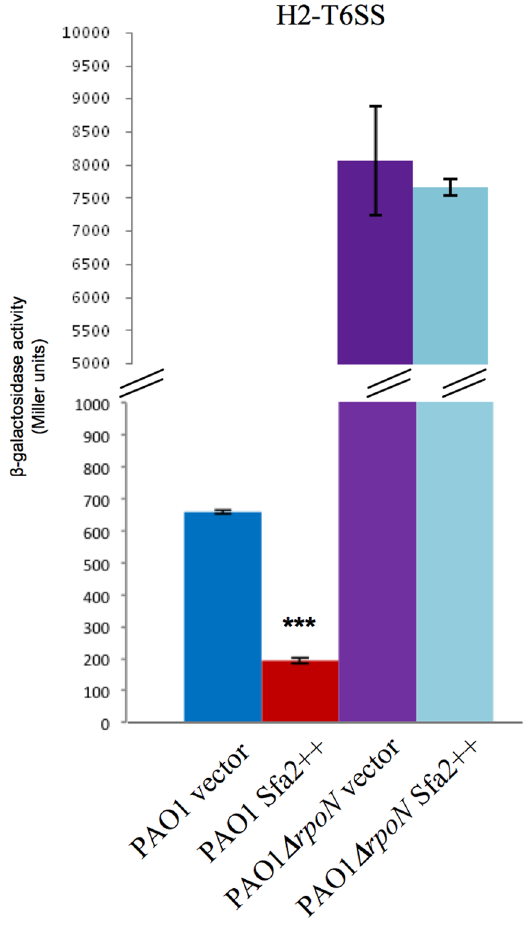
Figure 6. Sfa2 mediates down-regulation of H2-T6SS by RpoN Expression of H2-T6SS after 3.5 hours of growth at 37 u C in WT (blue and red bars) or rpoN mutant (purple and light blue bars) strains overproducing Sfa2 in trans (red or light blue bars), or without Sfa2 overproduction (empty vector, blue or purple bars). Expression is given in Miller units. For Sfa2 overproduction gene expression from the P BAD promoter was induced with arabinose (0.5%). Each experiment was done in triplicate and independently repeated three times; error bars indicate the standard deviation.